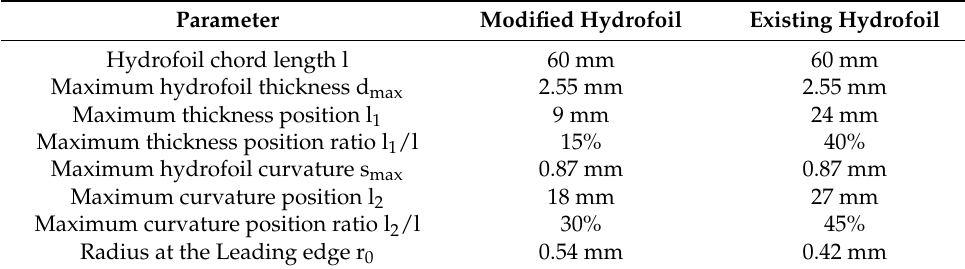
Table 2. Hydrofoil parameters.